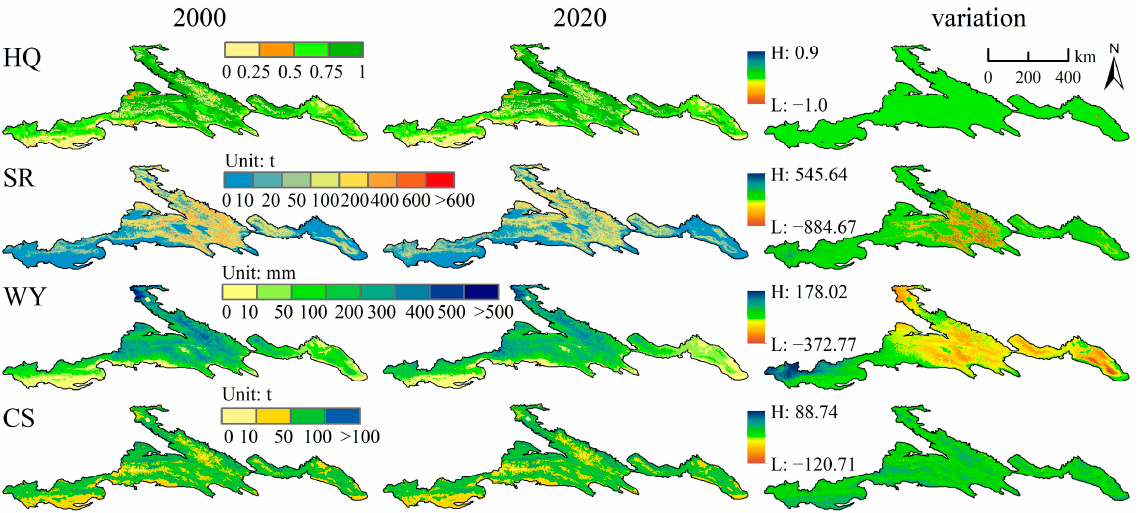
Figure 3. Spatial patterns of different ESs from 2000 to 2020 in the Tianshan Mountains. Note: HQ is habitat quality; SR is soil retention; WY is water yield; CS is carbon storage. SR showed a fluctuating downward trend, with an annual mean SR of 14.52 × 10 8 t over the 20 years in question. The maximum and minimum values of SR were 18.38 × 10 8 t in 2015 and 10.30 × 10 8 t in 2020, respectively. High-value areas were mainly distributed in the central and northern Tianshan Mountains, exhibiting a spatial distribution consistent with that of forests and grasslands. Low-value areas were mainly located in the western and eastern Tianshan Mountains, where vegetation coverage is low and soil erosion is severe. Over the two decades studied herein, SR did not change significantly, except for a significant decline in the central Tianshan Mountains. SR basically remained unchanged in 76.14% of the study region but declined in 22.00% of the